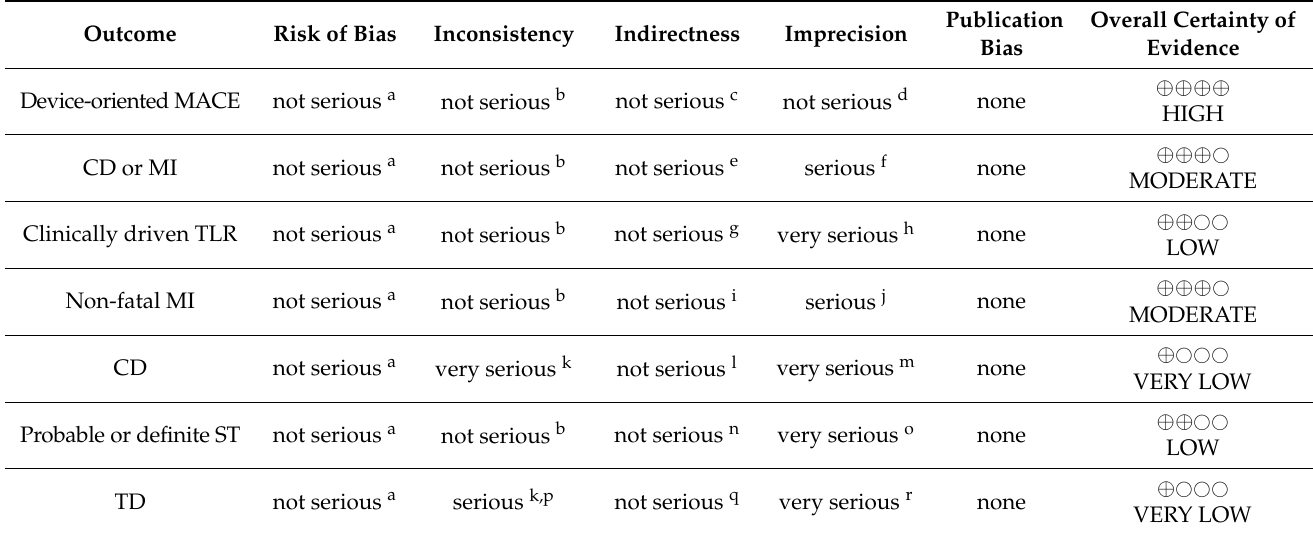
Table 3. GRADE Summary of findings—TiNOS vs. DES in ACS at 1-year